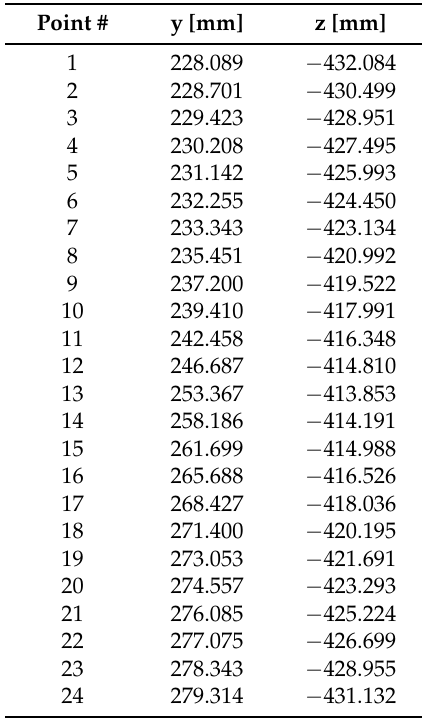
Table A4. Hemisphere datasets. (b) Plane X